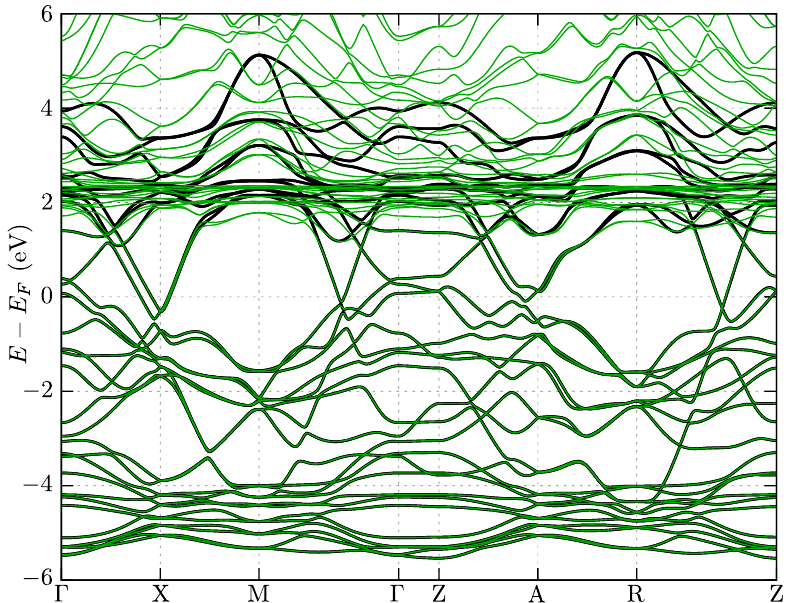
Figure A1. The comparison of the band structure obtained from the DFT calculations (green lines) and tight binding model (black